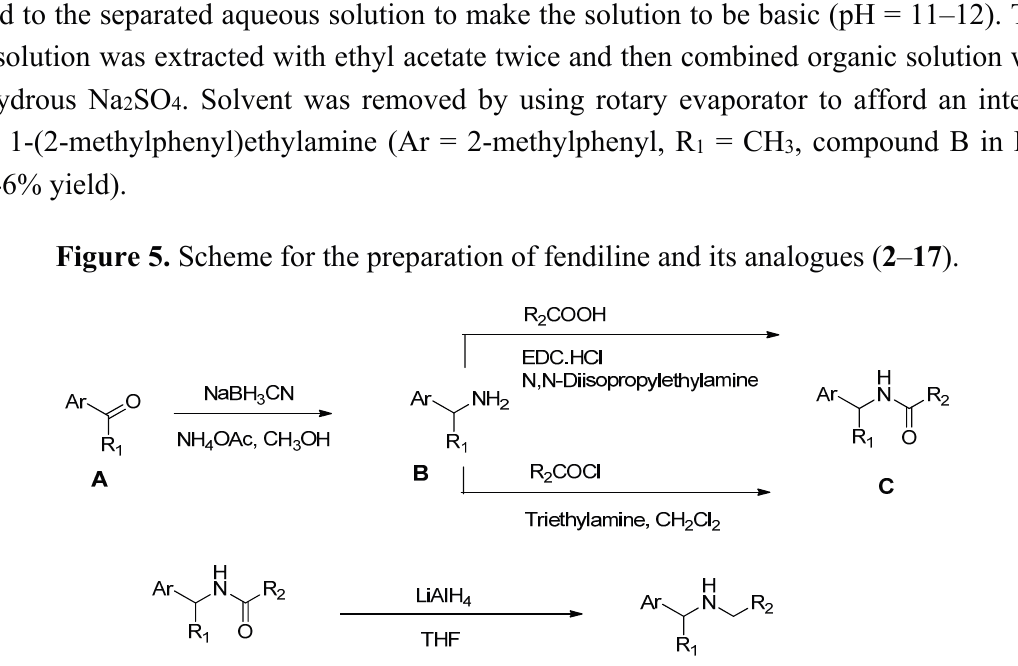
3,3-Diphenylpropionic acid (1.43 g, 10.5 mmol) was dissolved in methylene chloride (50